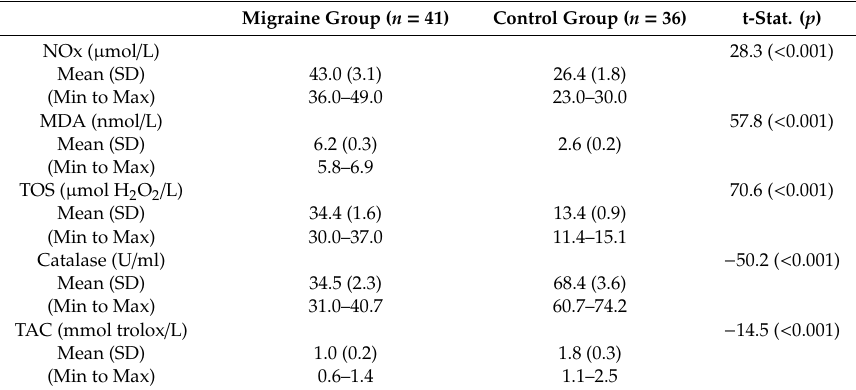
Table 1. Oxidative stress parameters by groups.